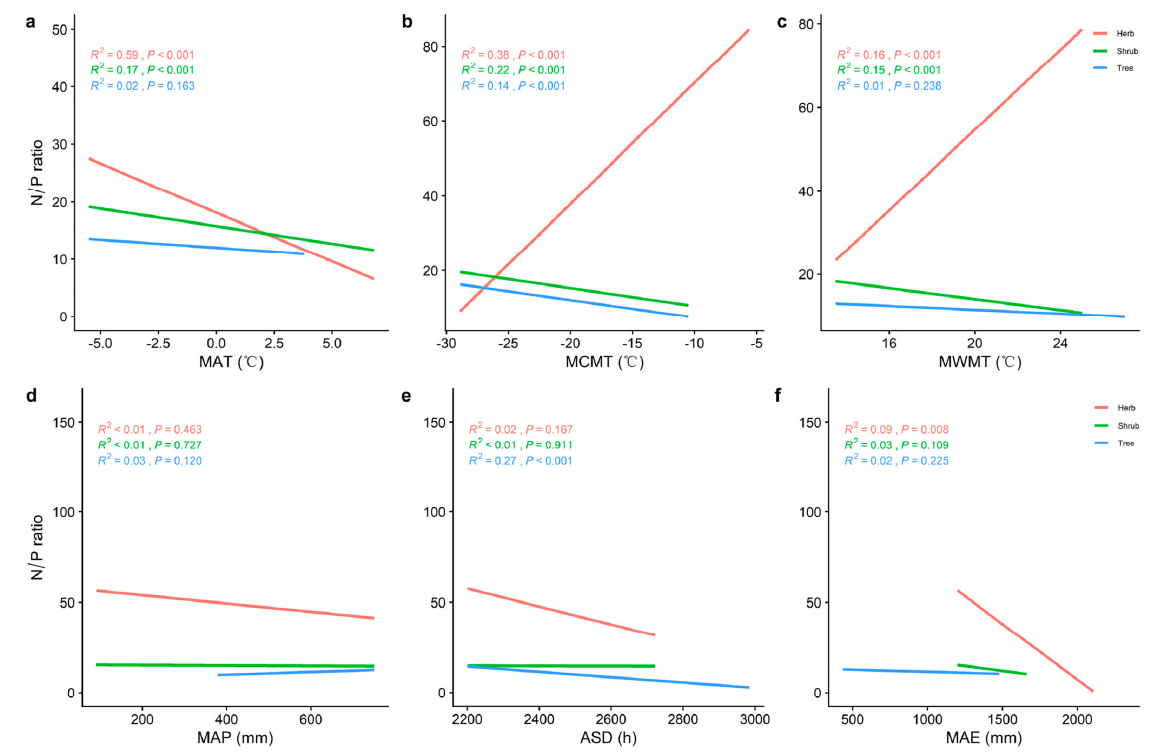
Figure 5. The general linear correlation analysis of climate factors with N/P at different life forms. ( a ) General linear relationship between the MAT and N/P of plants in the trees, shrubs, and herbs. ( b ) General linear relationship between the MCMT and N/P of plants in the trees, shrubs, and herbs. ( c ) General linear relationship between the MWMT and N/P of plants in the trees, shrubs, and herbs. ( d ) General linear relationship between the MAP and N/P of plants in the trees, shrubs, and herbs. ( e ) General linear relationship between the ASD and N/P of plants in the trees, shrubs, and herbs. ( f ): General linear relationship between the MAE and N/P of plants in the trees, shrubs, and herbs. MAT represents the mean annual temperature, MCMT represents the mean coldest monthly temperature, MWMT represents the mean warmest monthly temperature, MAP represents the mean annual precipitation, ASD represents the annual sunlight duration, and MAE represents the mean annual evaporation. The red line represents the tree level, the green line is the shrub level, and the blue line is the herb level. R 2 represents how well the model fits the variables studied and the P − value represents the significance level.